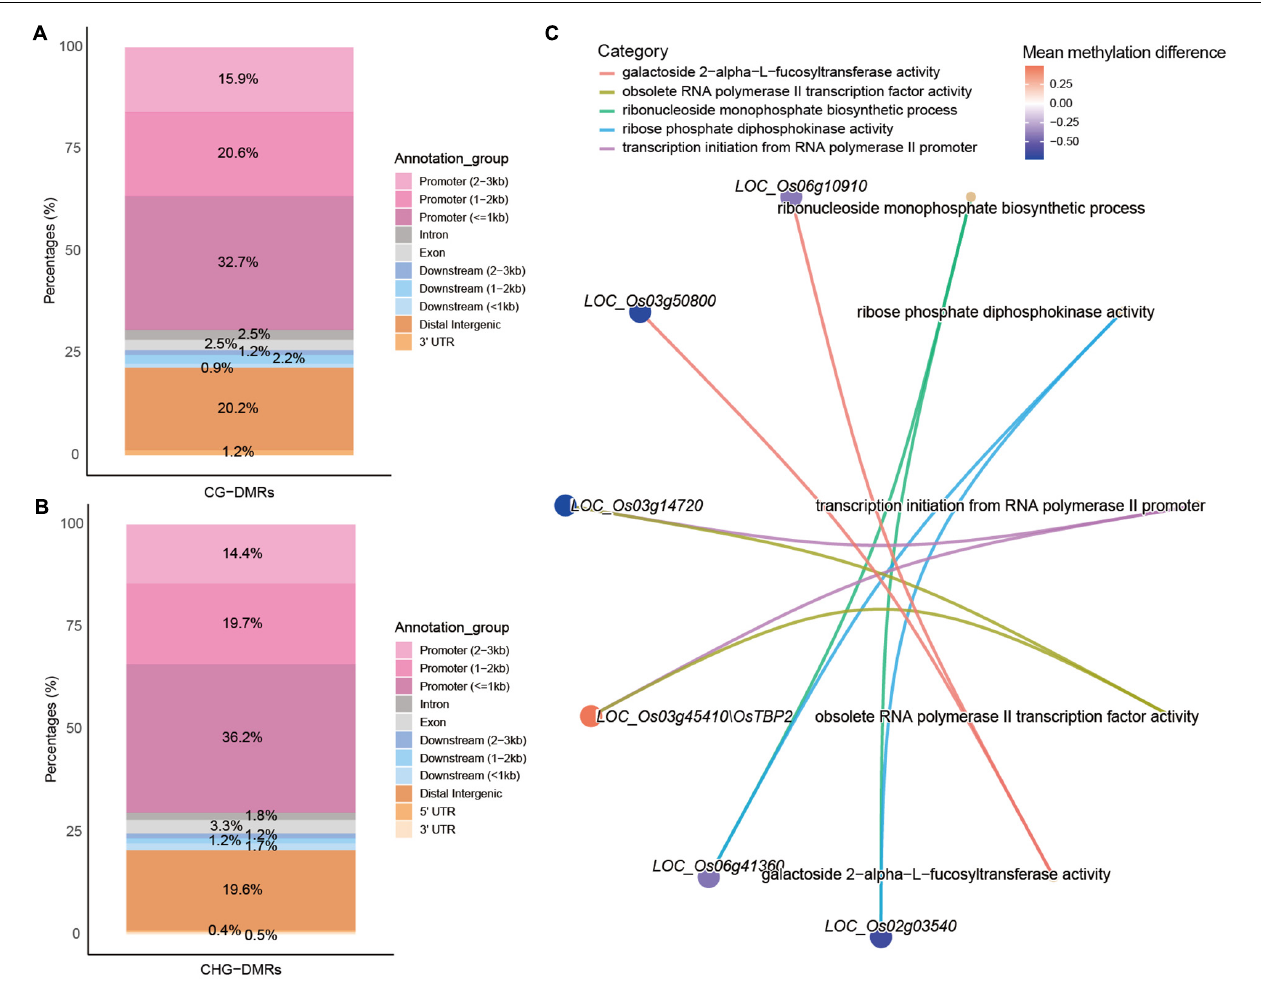
FIGURE 3 | Characterization of DMR-associated genes. The distributions of CG-DMRs (A) and CHG-DMRs (B) summarized according to the annotated genomic location. The order of the stacking bar charts is consistent with that of the legends on the right. (C) The network between genes and enriched GO terms. Genes are indicated as MSU loci or gene symbols. GO categories are displayed in the name of GO